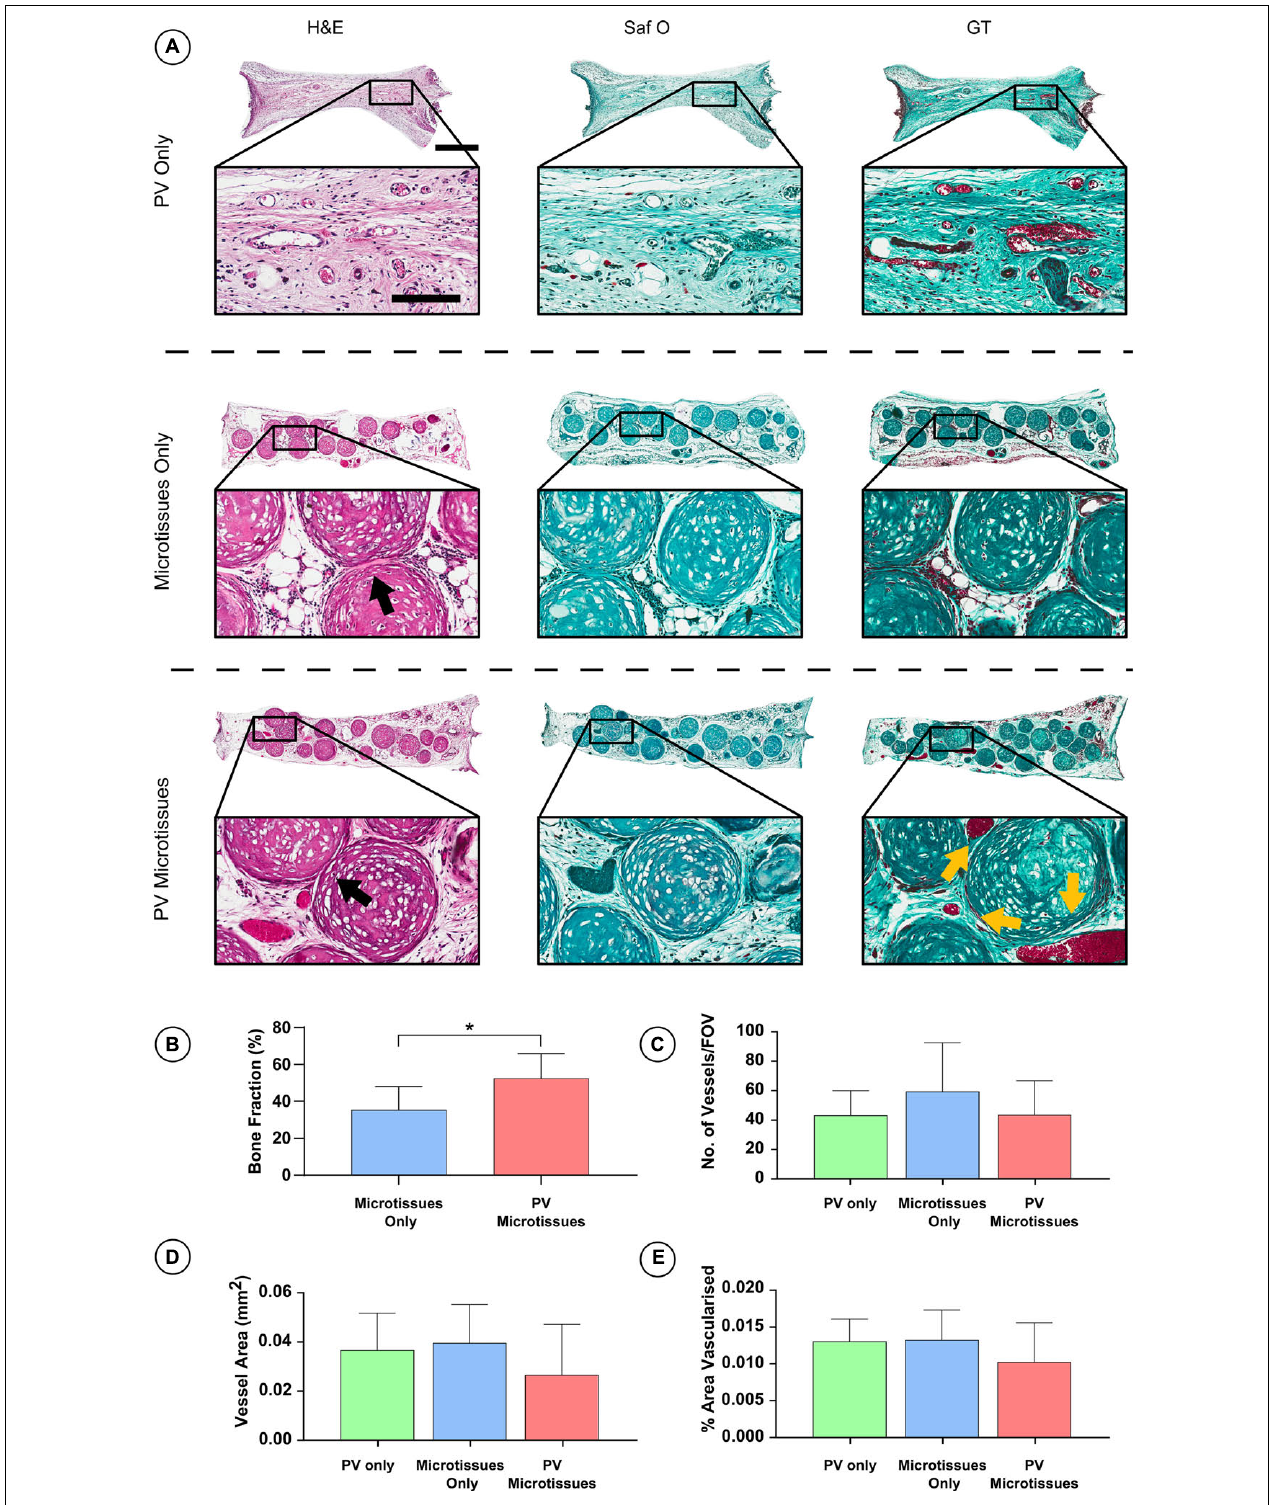
FIGURE 6 | Histological analysis of constructs 8 weeks post-implantation. (A) Haematoxylin and eosin staining (H&E), Safranin O staining (Saf O) and Goldner’s Trichome staining (GT) at 8 week Scale bar = 500 µ m for low resolution images; scale bar = 150 µ m for high resolution images (Black arrows indicate fusion & yellow arrows show blood vessels). (B) Quantification of bone fraction (C) quantification of vessel no. (D) Vessel area and (E) percentage vascularised area, *denotes significance two-way ANOVA with Tukey post hoc test, p < 0.05 ( n = 6 for PV microtissues and n = 4 for microtissue only and PV only, Mean ± SD).